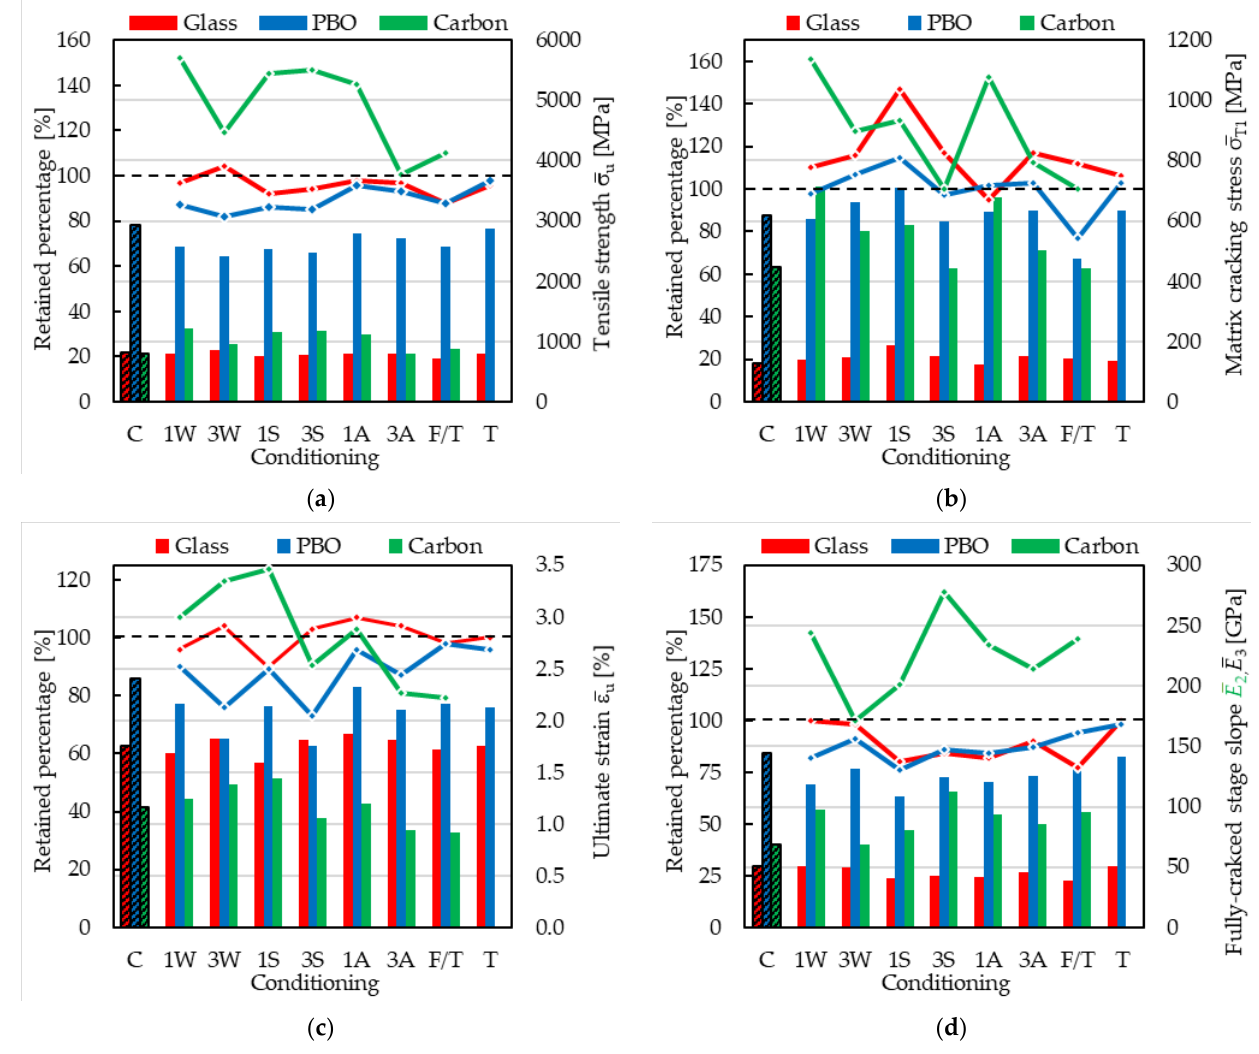
Figure 4. Average mechanical properties of FRCM composites after different environmental conditionings (histogram bars) and corresponding percentages of retained performances with respect to control specimens (line charts). ( a ) Tensile strength; ( b ) matrix cracking strength; ( c ) ultimate strain; ( d ) slope of the fully cracked stage. Nomenclature: C = Control specimens (unconditioned), W = Hygrothermal, S = Saline, A = Alkaline, F/T = Freeze – thaw cycles, T = maximum service temperature. Table 4. Carbon FRCM: average results of conditioned specimen groups and retained values. Conditioning